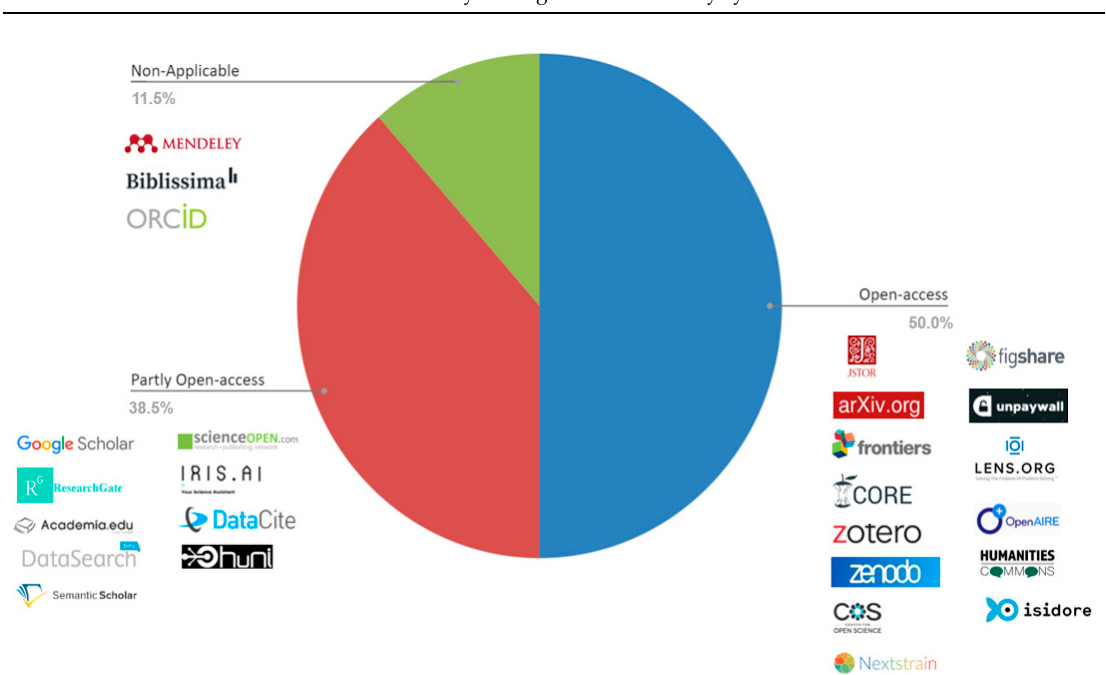
Figure 1. Analyzed platforms according to their status as “open access”, “partly open-access” or